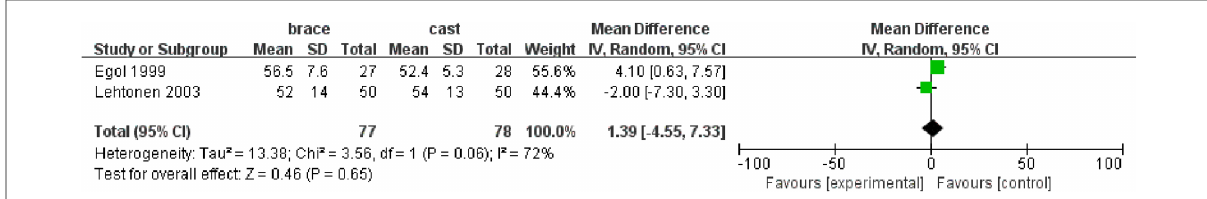
FIGURE 4 Forest plot of comparing cast versus brace groups for the 6w ankle score. CI, con fi dence interval.